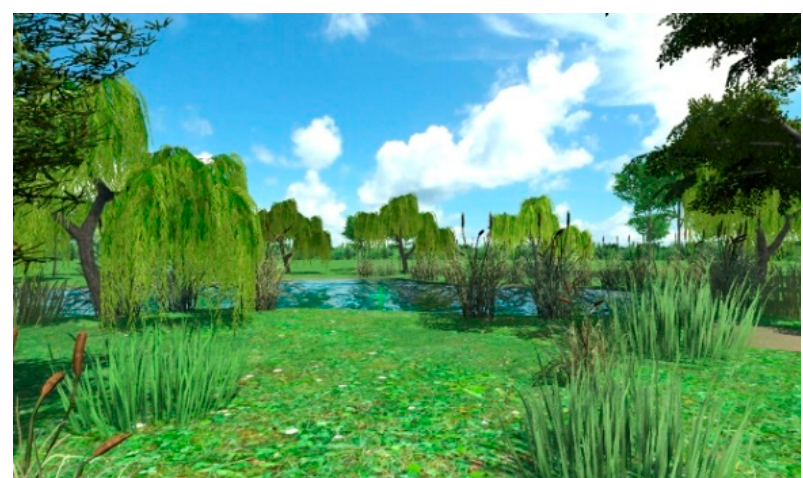
Figure 7. Screenshot 2 of a restorative garden scene.